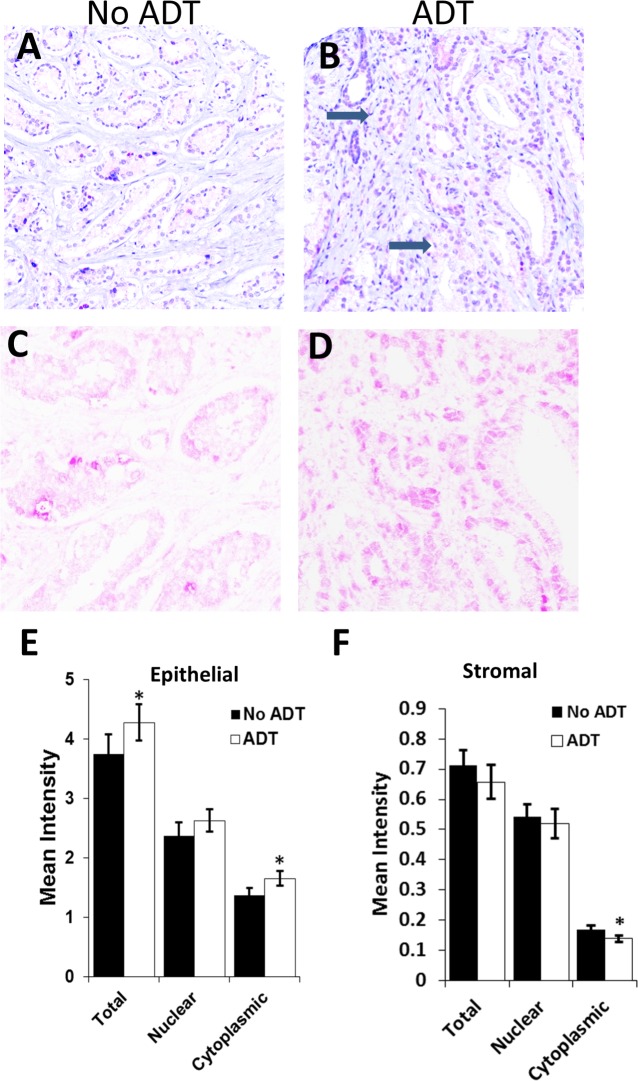
Higher GLB1 levels after neoadjuvant ADT in prostate cancer tumor tissues.Immunohistochemistry for GLB1 was performed on tissue arrays as described in the methods and staining quantitated automatically using VECTRA. Lower power H&E staining (20X) of control (A) and neoadjuvant (B) ADT treated intermediate grade prostate cancer tissues. Morphologic changes associated with ADT exposure include shrinkage/loss of acini (→) making Gleason scoring inapplicable. Increased levels of GLB1 (purple) are shown in nuclear and cytoplasmic compartments of ADT treated (D) and untreated (C) epithelium under higher power. (E) Epithelial (tumor) levels of GLB1 were significantly increased in ADT treated specimens overall and in the cytoplasm. (F) No significant increases in GLB1 expression in stromal tissue treated with ADT compared to untreated tissues. *p<0.05; mean±SE.